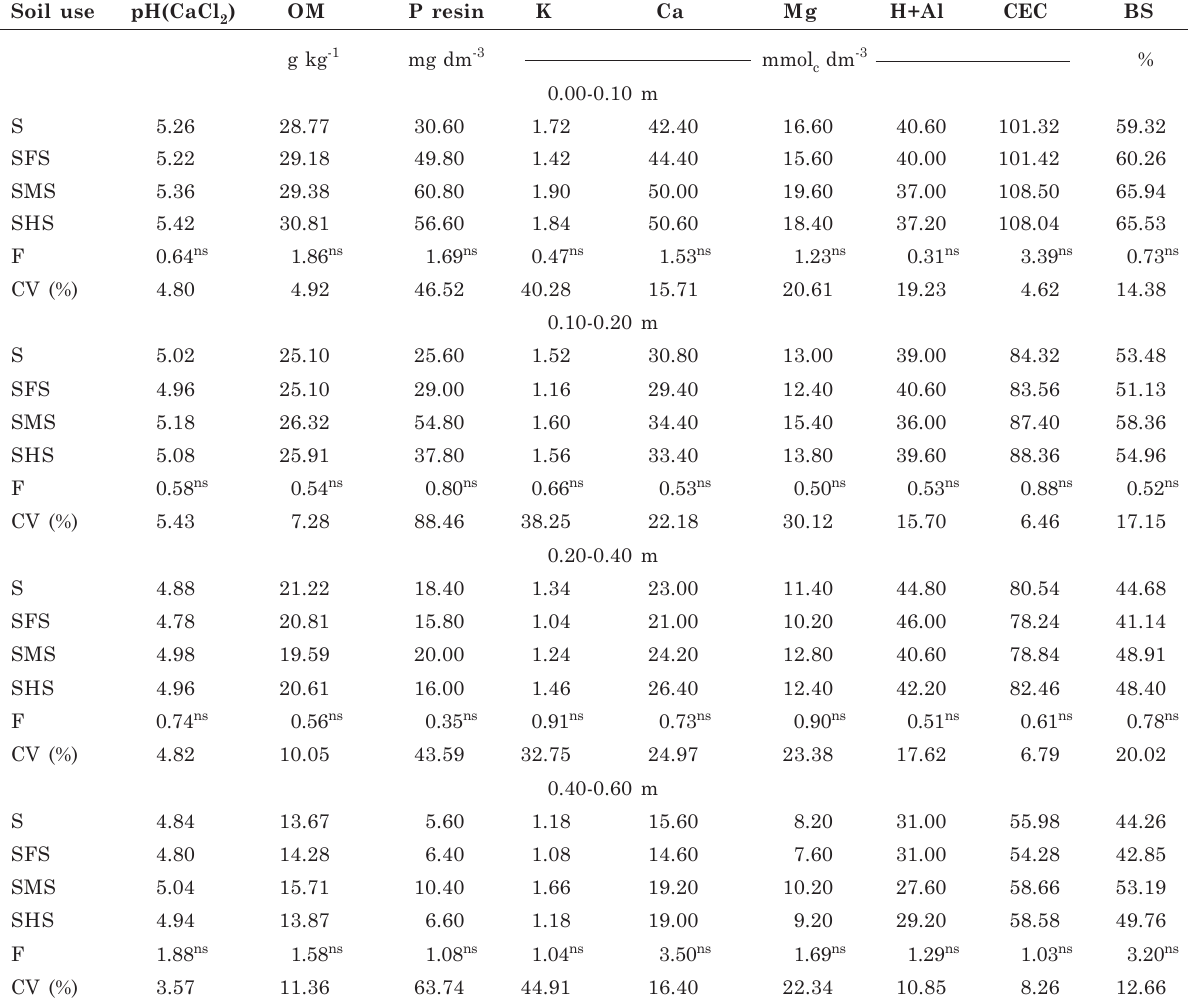
Table 1. Chemical properties of the eutroferric Red Latosol after the first sugarcane